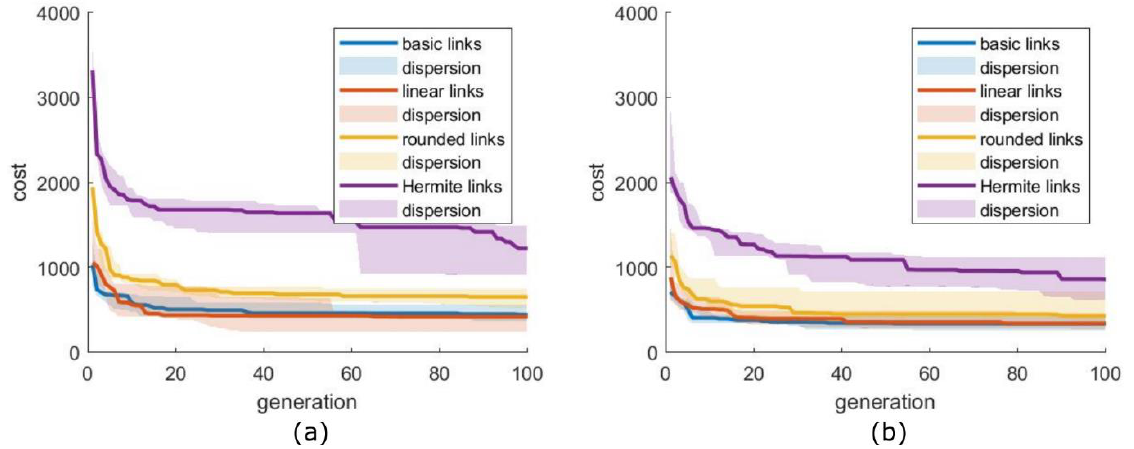
Figure 12. Results for task 1: ( a ) cost 1 ; ( b ) cost 2 .